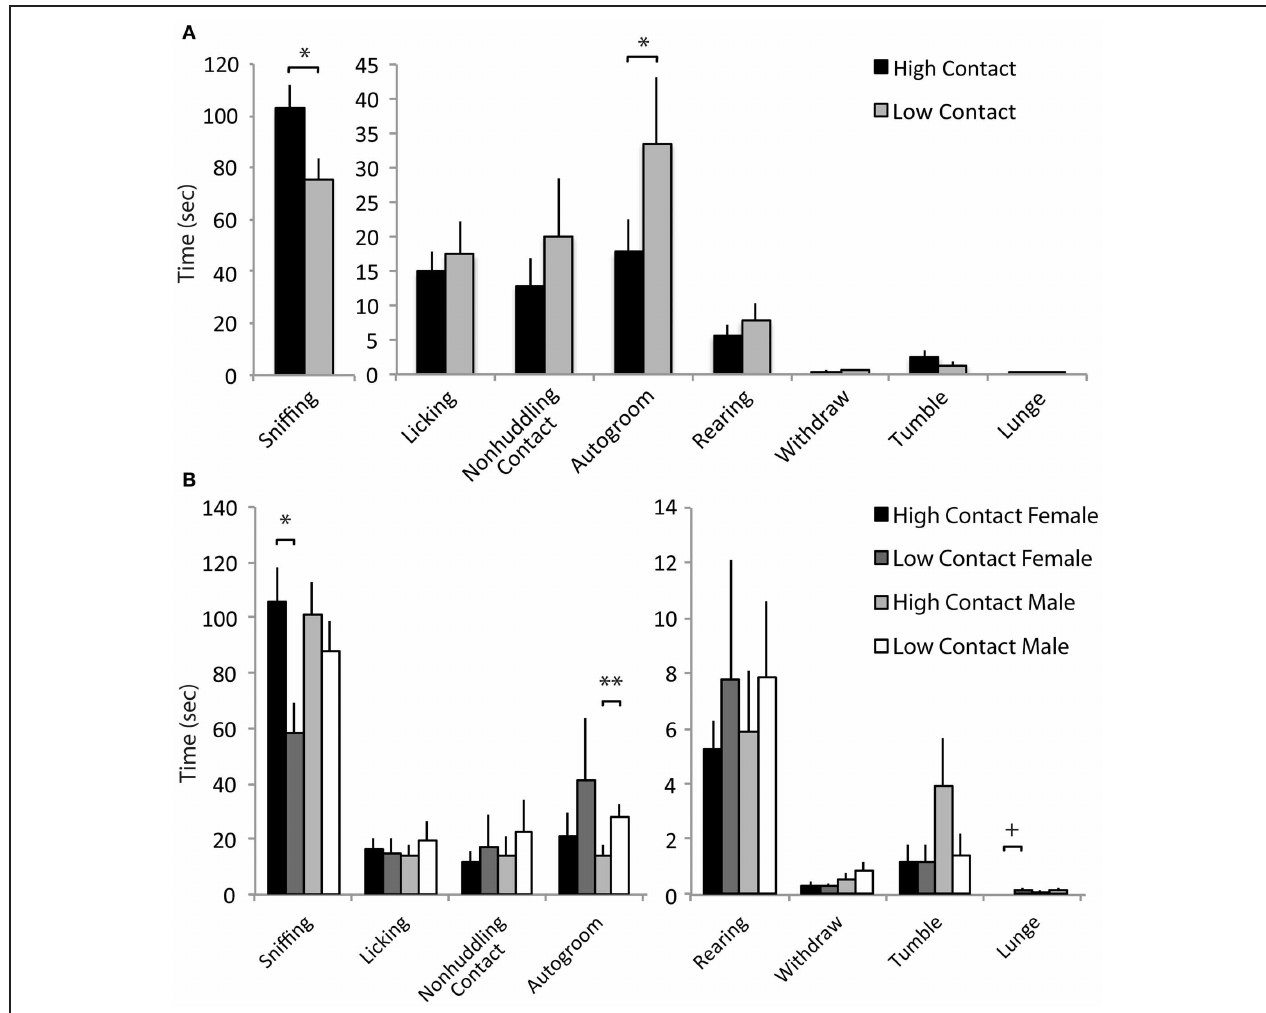
FIGURE 4 | Juvenile affiliation data. (A) High-contact offspring spent more time sniffing the novel juvenile [ F ( 1 , 70 ) = 5 . 51, p = 0 . 02] while low-contact offspring spent more time autogrooming [ F ( 1 , 70 ) = 4 . 35, p = 0 . 04]. (B) When split by sex, low-contact males spent more time